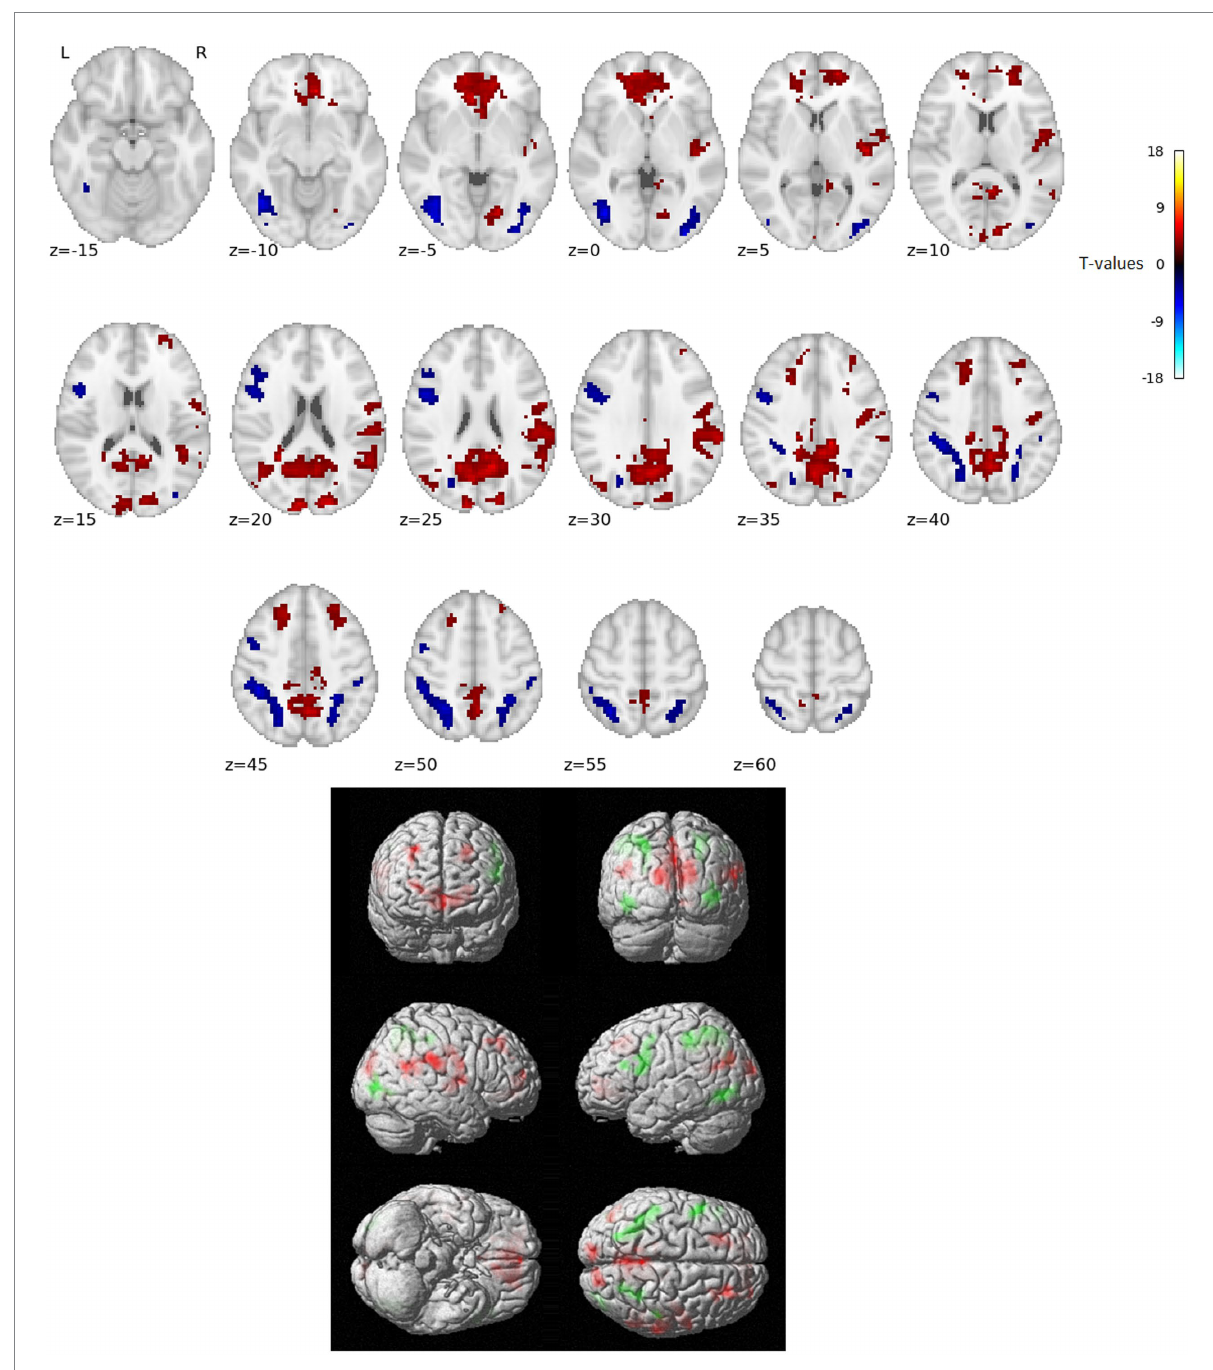
FIGURE 1 Statistically significant group effect of reading words vs. reading nonwords after RT effects were regressed out ( T -statistics). Red indicates neural activity stronger for reading words over and above RT effects, blue/green indicates neural activity stronger for reading nonwords over and above RT effects. Thresholded with p = 0.005 uncorrected for multiple comparisons at the voxel level and subsequently with p = 0.05 FWE corrected at the cluster level. Positions of slices in the z -axis in MNI space are indicated below the slices; L and R mark the left and right side,